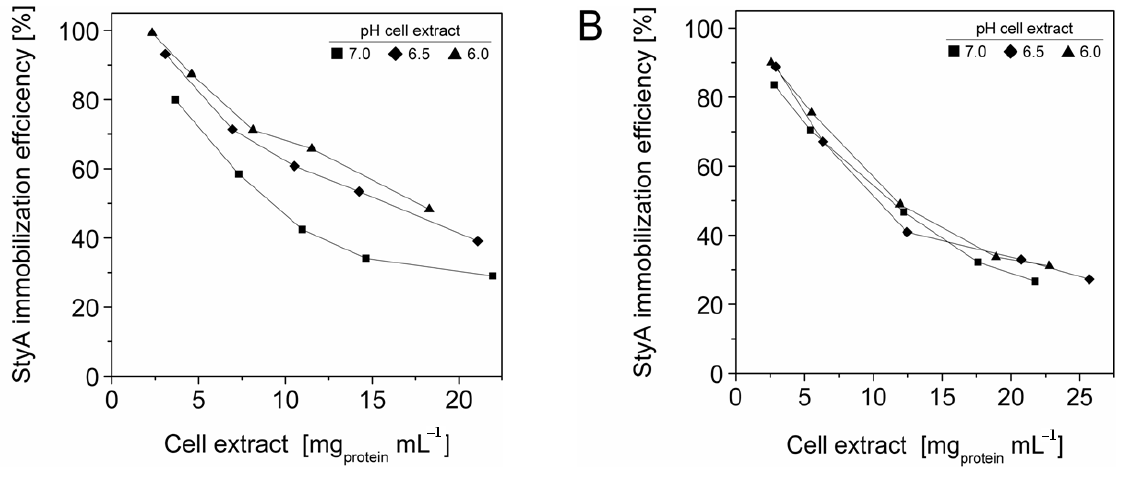
Figure 3. StyA immobilization efficiency from Escherichia coli JM101 (pSPZ10) cell extract on ( A ) Sepabeads EC-EA and ( B ) Sepabeads EC-Q1A at various pH values. Efficiencies are based on the ratios of adsorbed over soluble StyA at binding